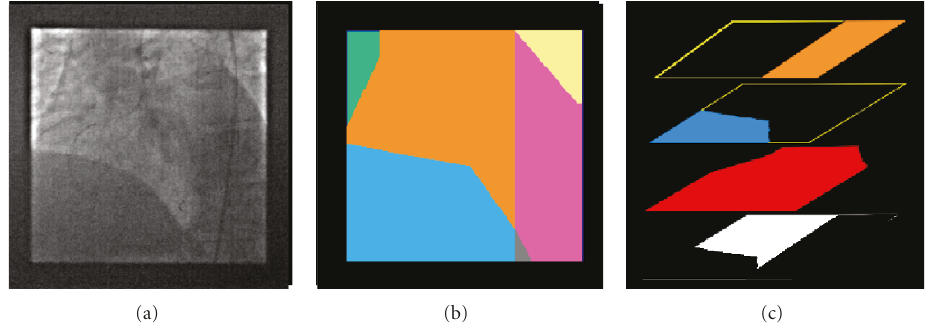
Figure 2: (a) One image of X-ray exam yielding a situation of bidistributed transparency. (b) The segmentation of the image in its di ff erent regions: three two-layer regions (the orange region corresponds to the “heart and lungs”, the light blue one to “heart and diaphragm” and the pink one to “heart and spine”), two single-layer regions (the lungs in green and spine in yellow), and a small three-layer region (“heart and diaphragm and spine” in grey). (c) Its spatial segmentation into four transparent layers (i.e., their spatial supports, spine in orange, diaphragm in blue, heart in red and lungs in white). By definition, the spatial supports of the transparent layers overlap. The colors have been independently chosen in these two